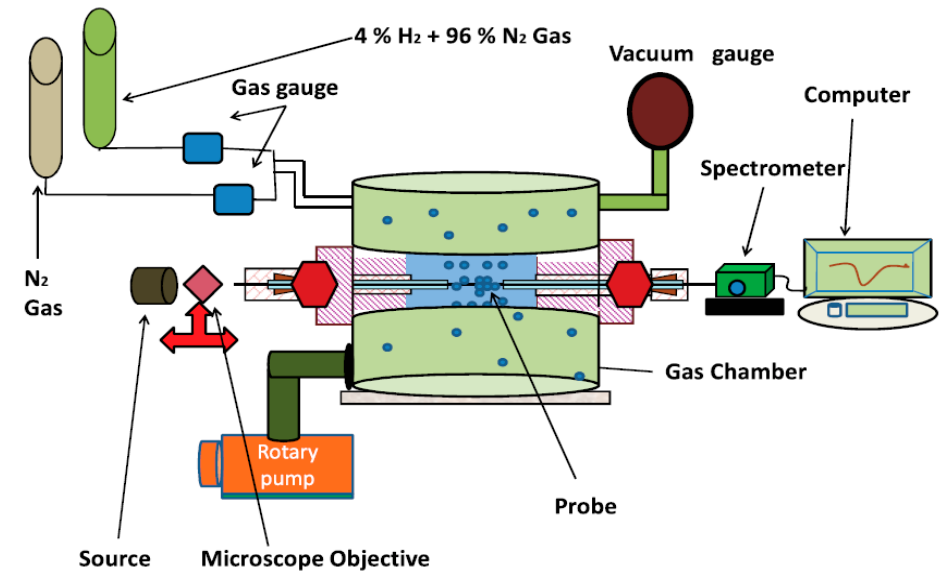
Figure 7. A schematic view of experimental gas-sensing system for designing LMR-based hydrogen gas sensor. Reproduced with permission from [57], copyright IOP Publishing.